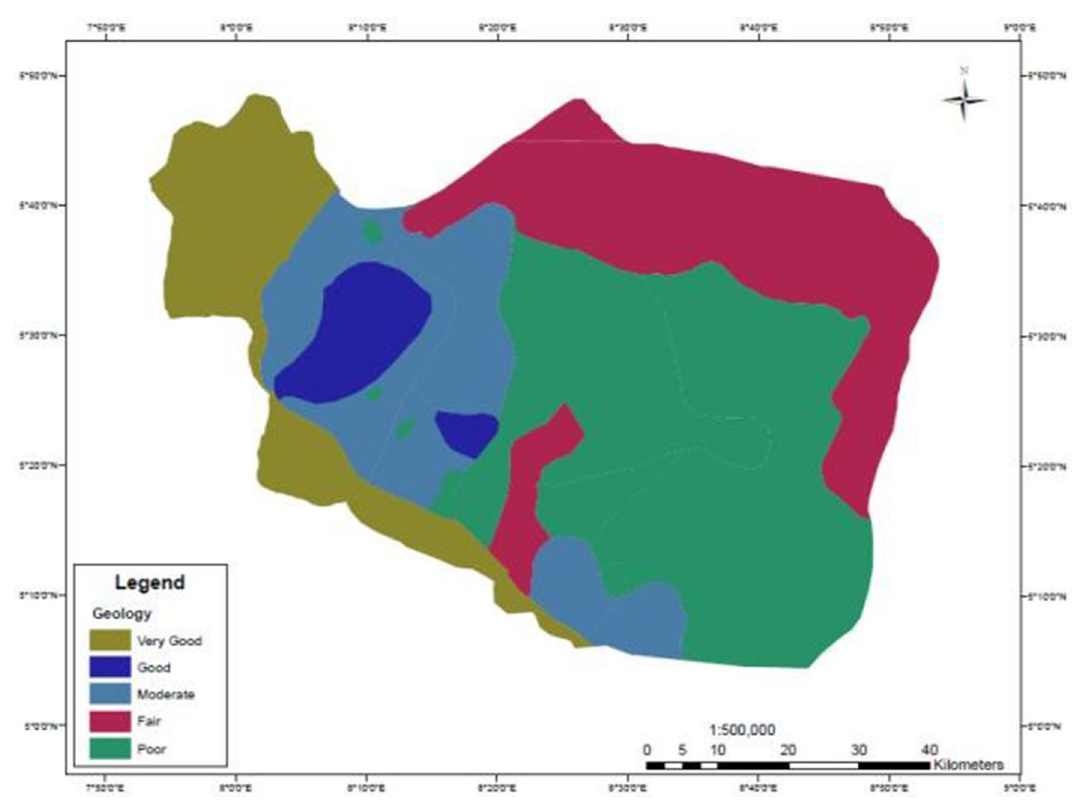
Fig. 4 Geological groundwater prospect map of the study